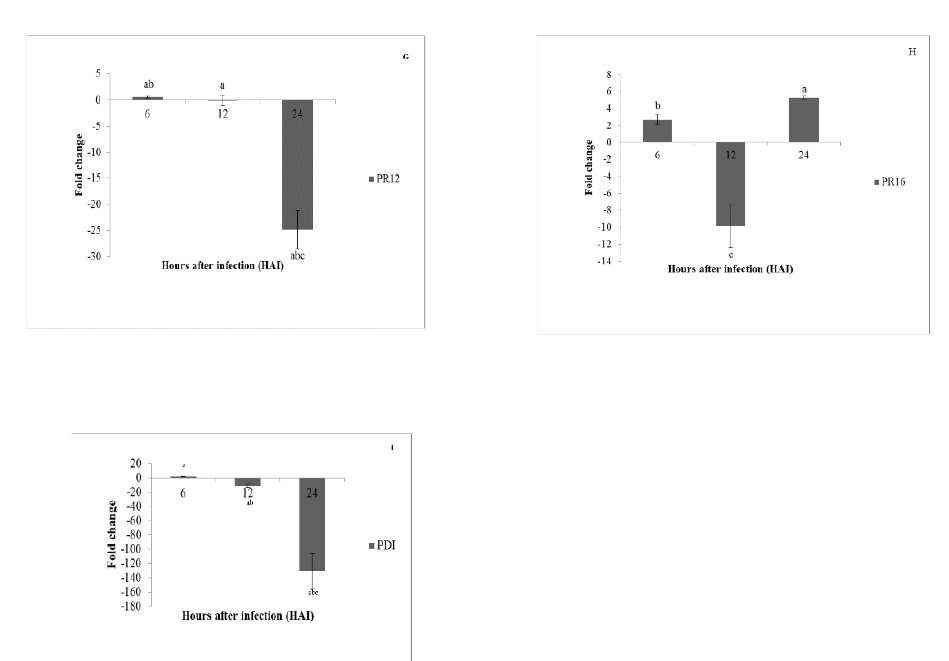
Figure 7. Temporal changes in PR gene ( A . PR2, B . PR3, C . PR4, D . PR5, E . PR9, F . PR10, G . PR12, H . PR16, I . PDI) expression of Triticum aestivum (var. GW322) on endophytic ( P. aeruginosa PM389) challenge from 0–24 HAI. Vertical bars represent standard deviation. The mean values were compared, using Duncan’s multiple range test (DMRT) at p < 0.05. Values that were significantly different from each other are headed by different letters in each bar of treatment.